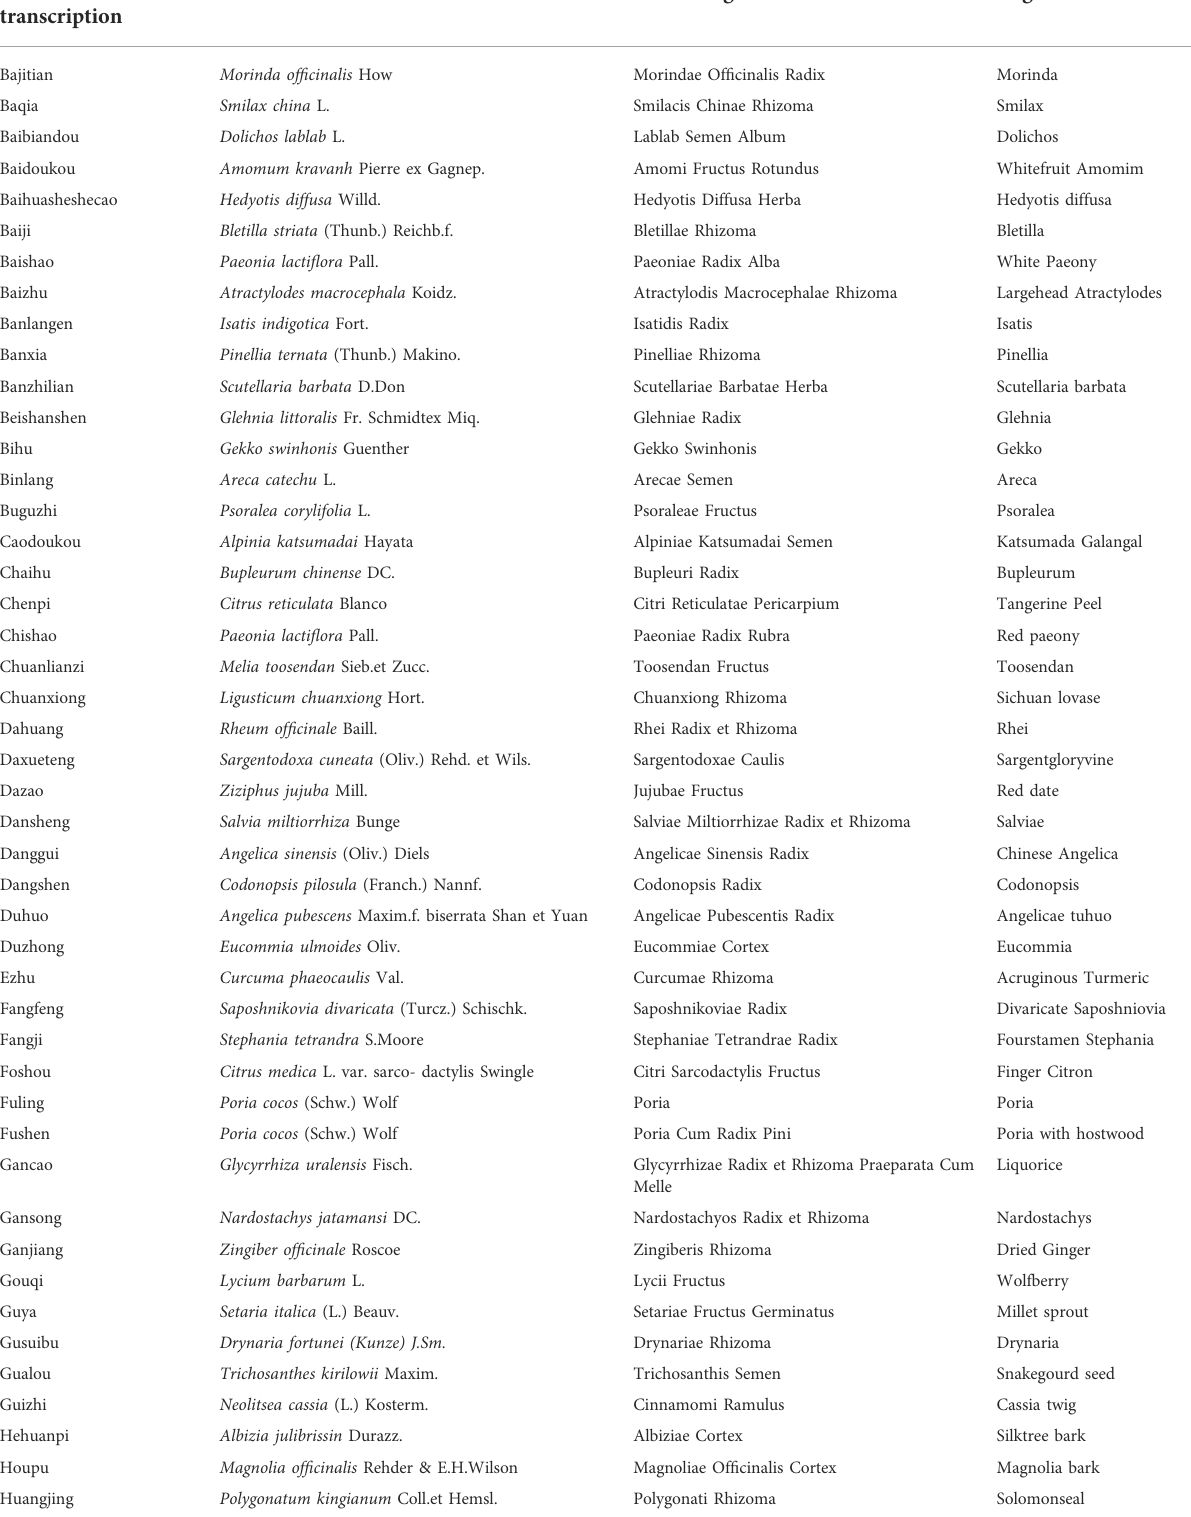
TABLE 3 The names of